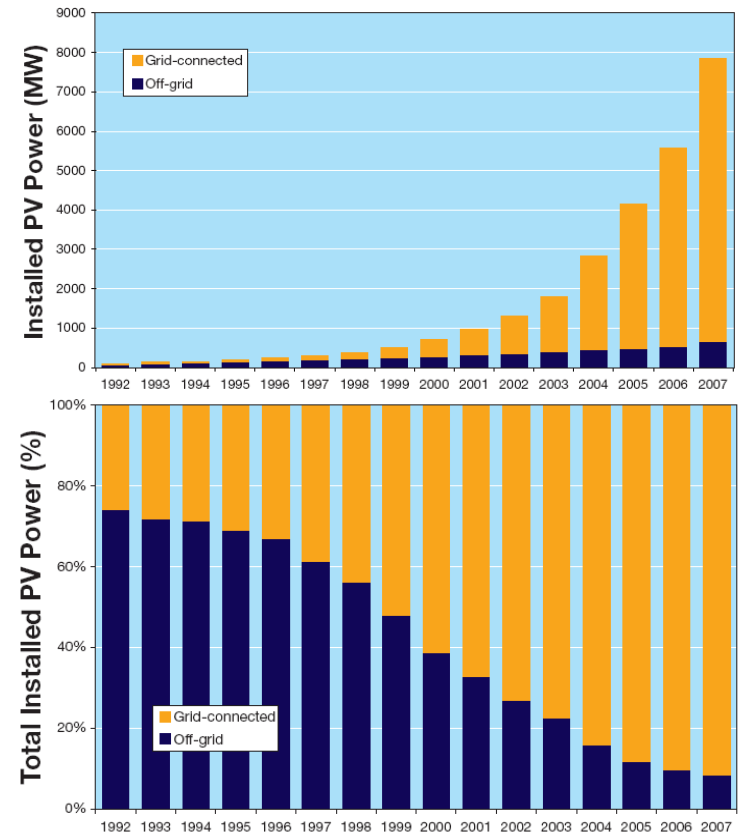
Figure 63. Grid-connected versus off-grid PV capacity. © 2008 OECD/IEA, reproduced from [54] with